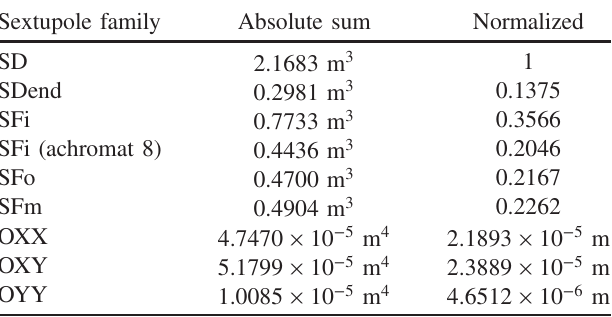
TABLE I. The effect of each magnet family on the OEORM. The value is calculated by taking the absolute sum of the circuits contribution to the Jacobian. The effect of the octupoles are several orders of magnitude smaller than that of the sextupoles and can therefore safely be excluded from the fitting procedure. each consist of one magnet instead of